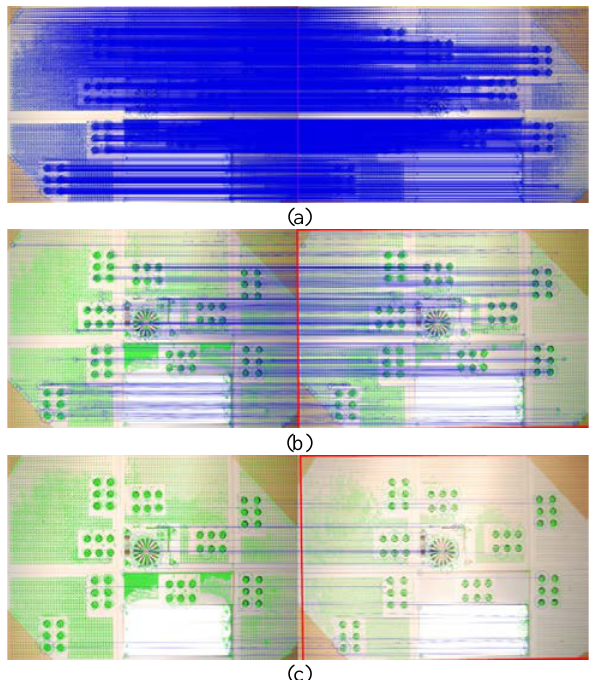
Figure 3. Results of automatic feature detection and connection using SURF and Brute Force matching after filtering out incorrect matches using sensor position. Left image is a sharp reference image. Blue lines and circles indicate connected feature points, green indicate detected feature points, red indicates image overlap. (a) Right image without camera displacement. (b) Right image with 0.377 mm camera displacement. (c) Right image with 1.028 mm camera displacement.